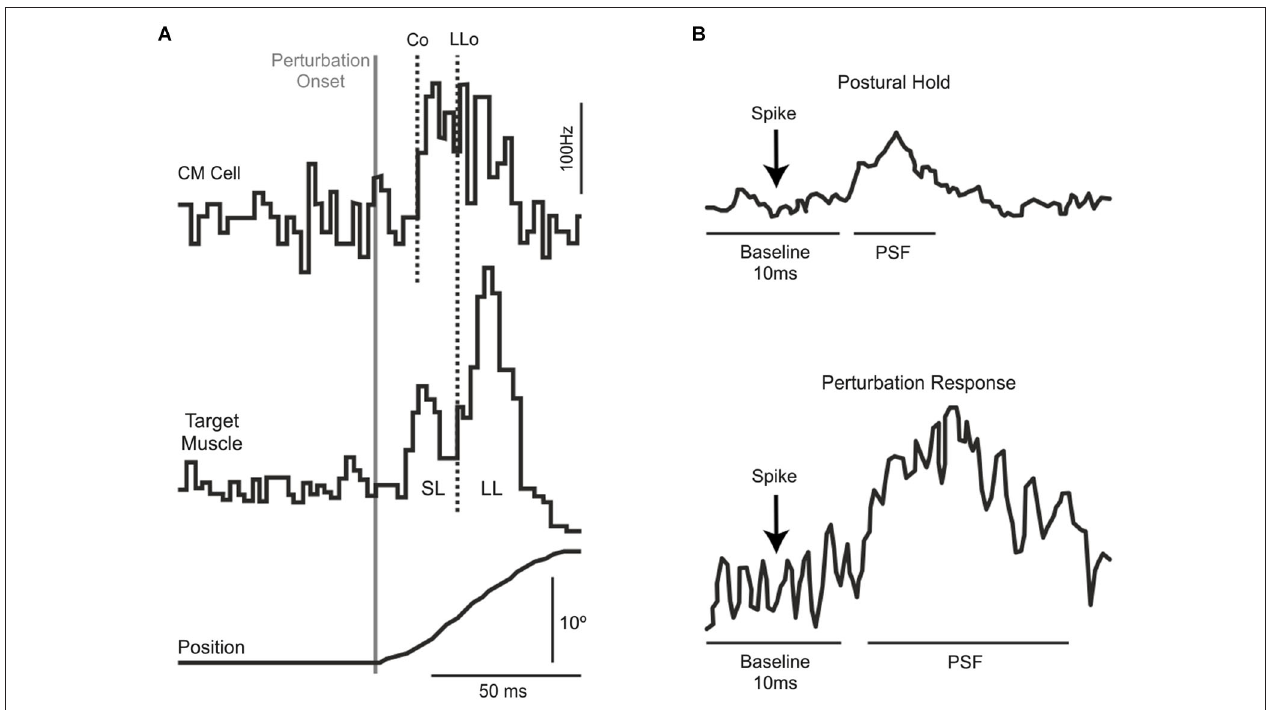
the long-latency response in the target muscle (LLo). (B) Spike-triggered averages in the target muscle during postural maintenance (top) and after mechanical perturbation onset (bottom). Note the increased post-spike facilitation during the perturbation epoch. Panels (A) and (B) modified with permission from Cheney and Fetz